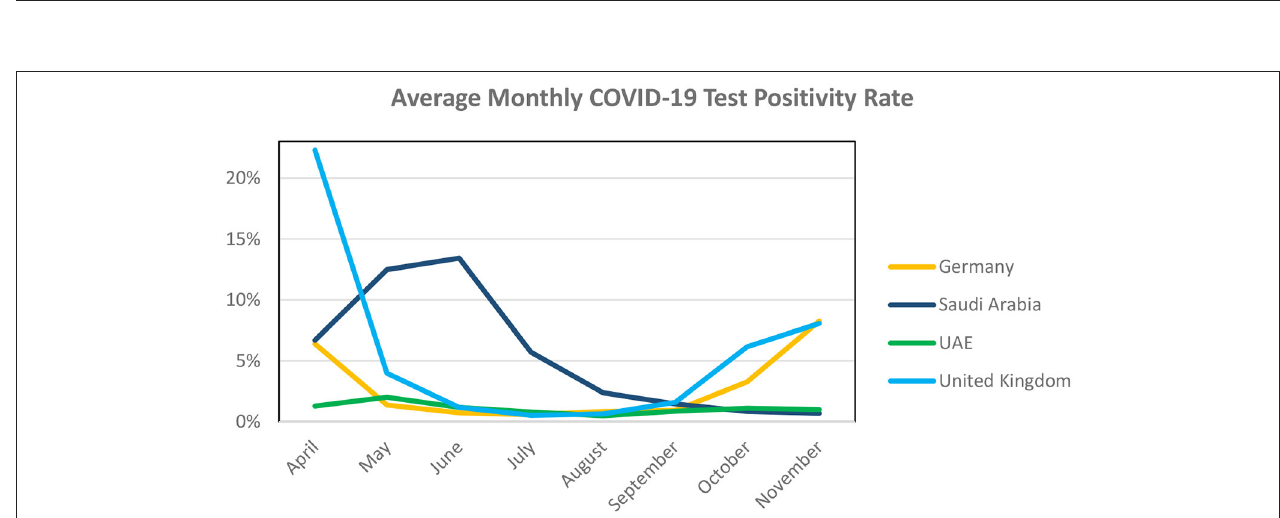
FIGURE 4 | Average monthly COVID-19 test positivity rates. Source: Our World Data.